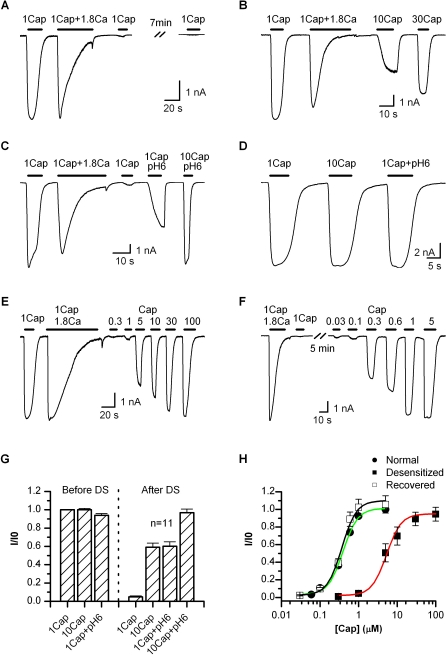
Adaptation of TRPV1(A) Whole-cell recording showing irreversible loss of the channel response to 1 μM capsaicin after desensitization. In the absence of Ca2+, 1 μM capsaicin activated a saturating current priori to desensitization, and became irresponsive after desensitization by 1 μM capsaicin plus 1.8 mM Ca2+. Cells were bathed in Ca2+-free solution, and the pipette solution contained no ATP to prevent recovery from desensitization.(B) Partial reactivation after desensitization by supramaximal capsaicin. 10 μM capsaicin was able to evoke a current nearly half of the initial response. Increasing the concentration to 30 μM both speeded up the activation and increased the peak response.(C) Attainment of the maximum response after desensitization by a combination of high capsaicin and low pH. 1 μM capsaicin at (pH 6) was like 10 μM capsaicin, producing only a partial response with a slow activation rate, while 10 μM capsaicin at (pH 6) gave rise to a current similar to the initial 1 μM capsaicin response.(D) Control recording showing that 1 μM capsaicin (Ca2+-free) was saturating at the rest condition. Bath and pipette solutions similar to (A).(E–F) Representative traces illustrating the responsiveness to various capsaicin concentrations after desensitization (E) or recovered from desensitization (F). The recovery was promoted by 4 mM ATP included in the pipette solution. A full recovery of the channel responses was typically observed in 5–10 min.(G) Average plot of the peak responses before and after desensitization. The desensitization diminished the 1 μM capsaicin response. A full reactivation required at least 10 μM capsaicin plus pH 6.(H) Dose-response relations of the desensitized channel in comparison with those at resting or after recovered from desensitization. Data were normalized to the initial 1 μM capsaicin response in each cell. Fitting by Hill's equation gave EC50 = 0.40 ± 0.02 μM, nH = 2.3 ± 0.3 (control); EC50 = 0.37 ± 0.04 μM, nH = 2.0 ± 0.3 (recovered); EC50 = 5.29 ± 0.48, nH = 1.9 ± 0.4 (desensitized). Recordings from transiently transfected HEK 293 cells held at −60 mV. Capsaicin perfusion solutions either contained 1.8 mM Ca2+ or was Ca2+-free, as indicated above the traces.